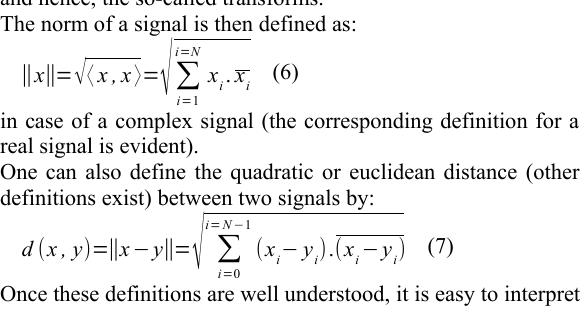
which only a few coefficients of the linear combination of the is a perturbation in the initial signal. Then, in the